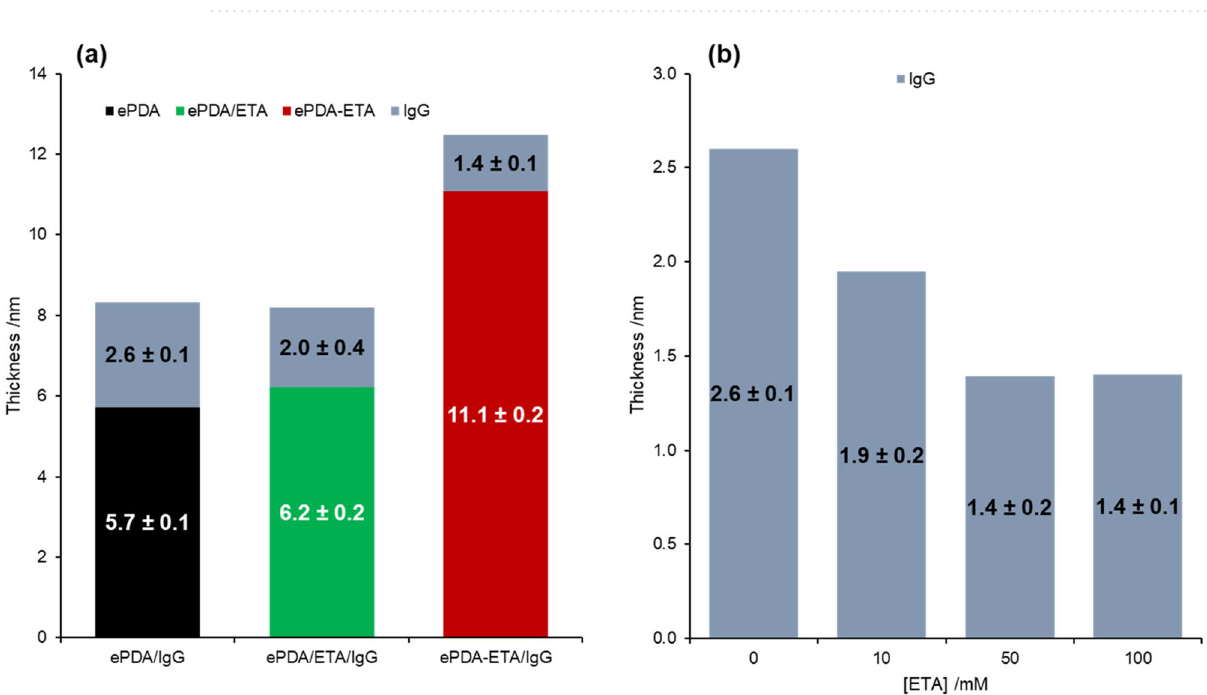
Figure 6. ( a ) Optical thicknesses of pristine polydopamine (ePDA), two-step modified polydopamine (ePDA/ ETA) and one-step modified polydopamine (ePDA-ETA), before and after IgG incubation on the several polymers. ( b ) Effect of ethanolamine concentration during ePDA-ETA electrosynthesis on the IgG layer